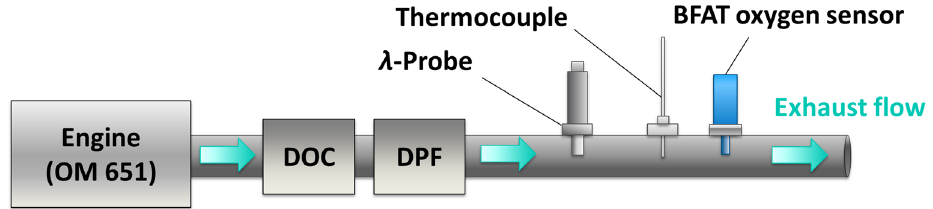
Figure 10. Schematic illustration of the measurement setup on the engine test